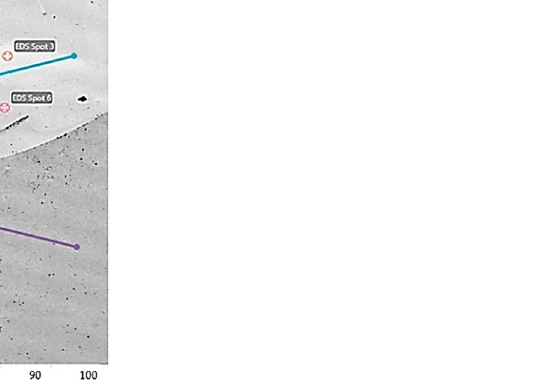
Figure 8. Chemical composition analysis near the fusion line between weld and S235 JR steel. Table 3. Chemical composition, wt.%, in the measurement points shown in Figure 8.